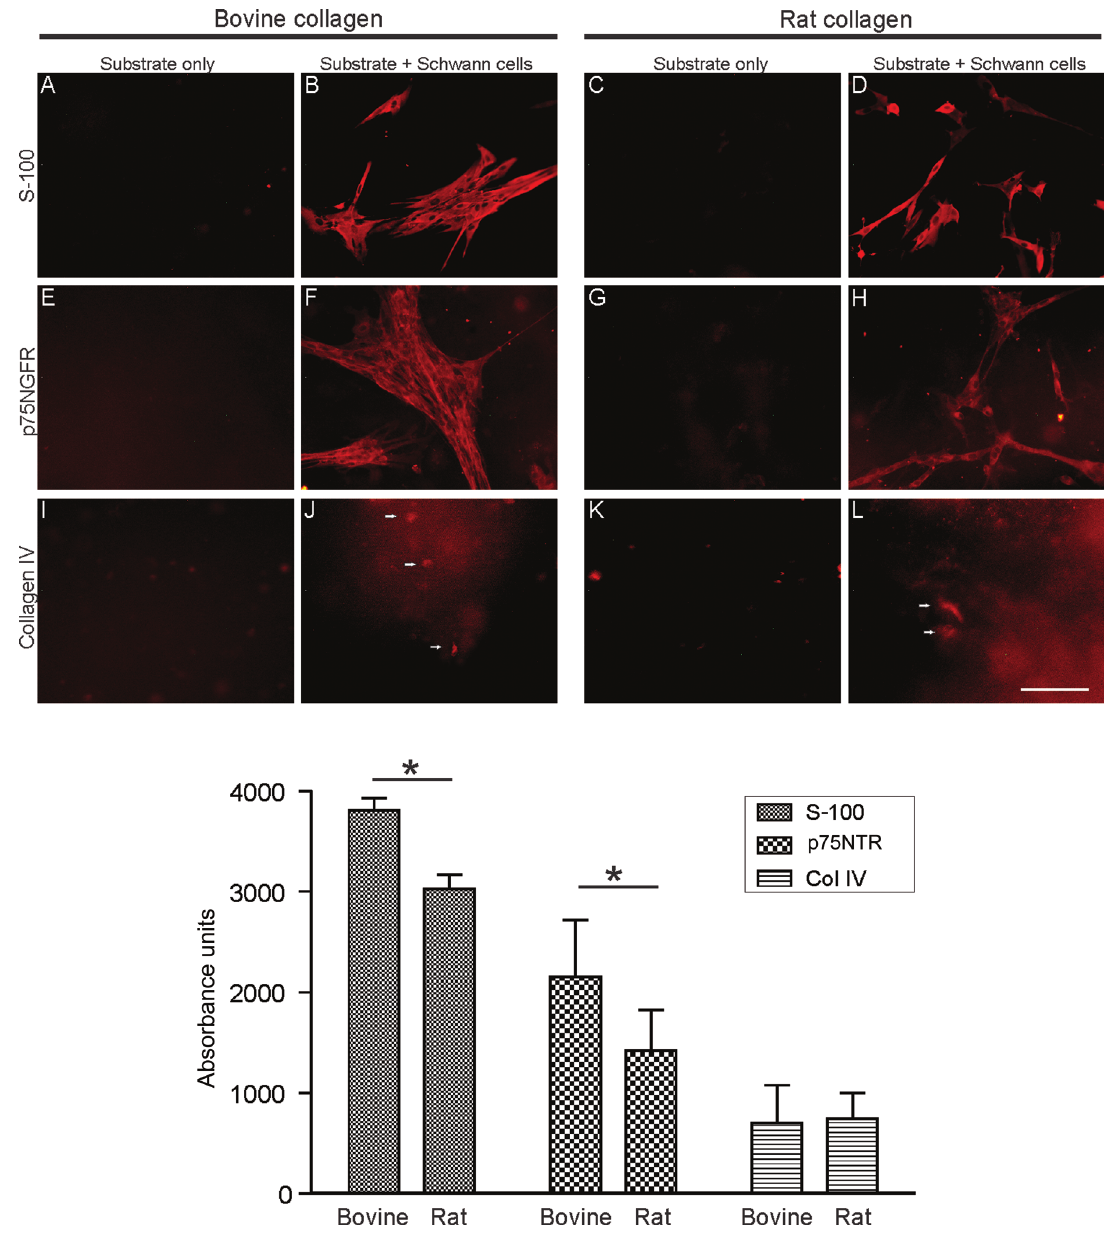
Figure 2. Comparison between Schwann cell cultures performed on supraorganized (bovine collagen) and on non-organized collagen (rat collagen). A and C, Substrate only (control) immunolabeled against S-100. B and D , Schwann cells cultured on bovine and rat collagen, respectively, and immunolabeled against S-100. Note the better alignment of SCs on the orga- nized collagen. E and G, Substrate only (control) immunolabeled against p75NTR (p75 pan neurotrophin receptor). F and H , Schwann cells cultured on bovine and rat collagen, respectively, and immunolabeled against p75NTR. Note the better alignment and increased number of SCs on the organized collagen. I and K, Substrate only (control) immunolabeled against type IV collagen. J and L , Schwann cells cultured on bovine and rat collagen, respectively, and immunolabeled against type IV collagen. No differences were observed between the different substrates. Labeled cells are indicated by arrows. Bar = 100 µm. The bottom panel contains the quantitative data for the immunolabeling against S-100 (B and D), p75NTR (F and H) and type IV collagen (Col IV, J and L). Data are reported as means ± standard error of the mean. *P < 0.05 (one-way